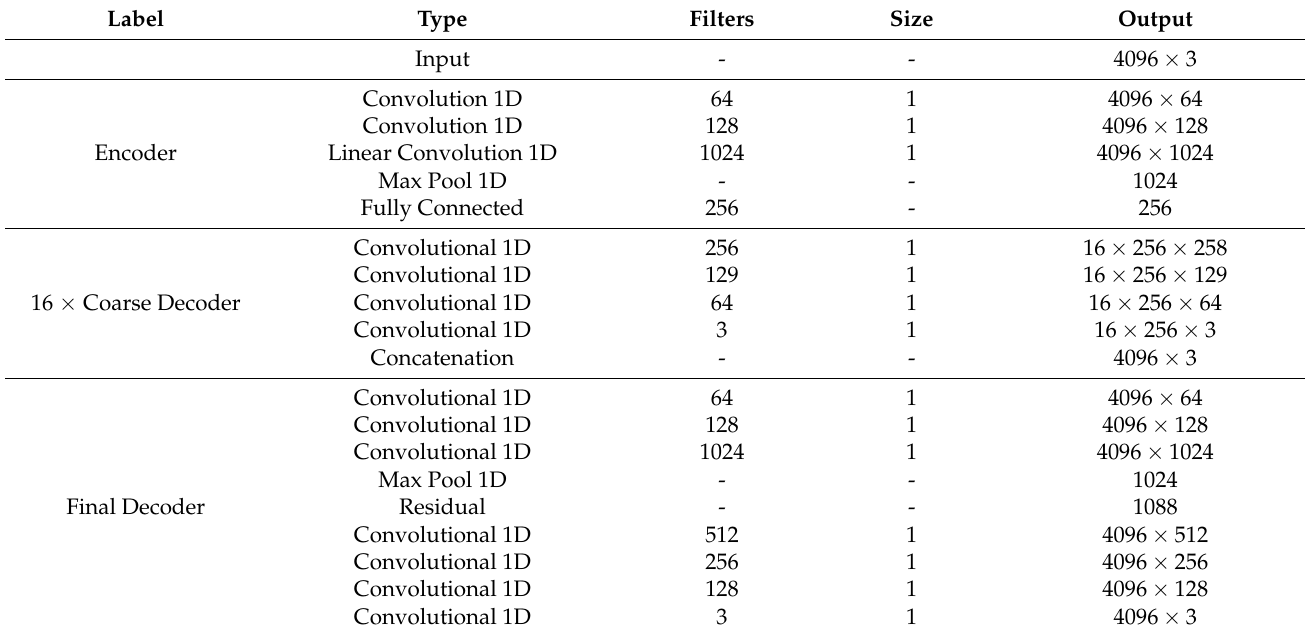
Table 3. Architecture of the reconstruction neural network. We use 16 Morph-Based-Decoders for 16 potential surfaces for the network to be able to